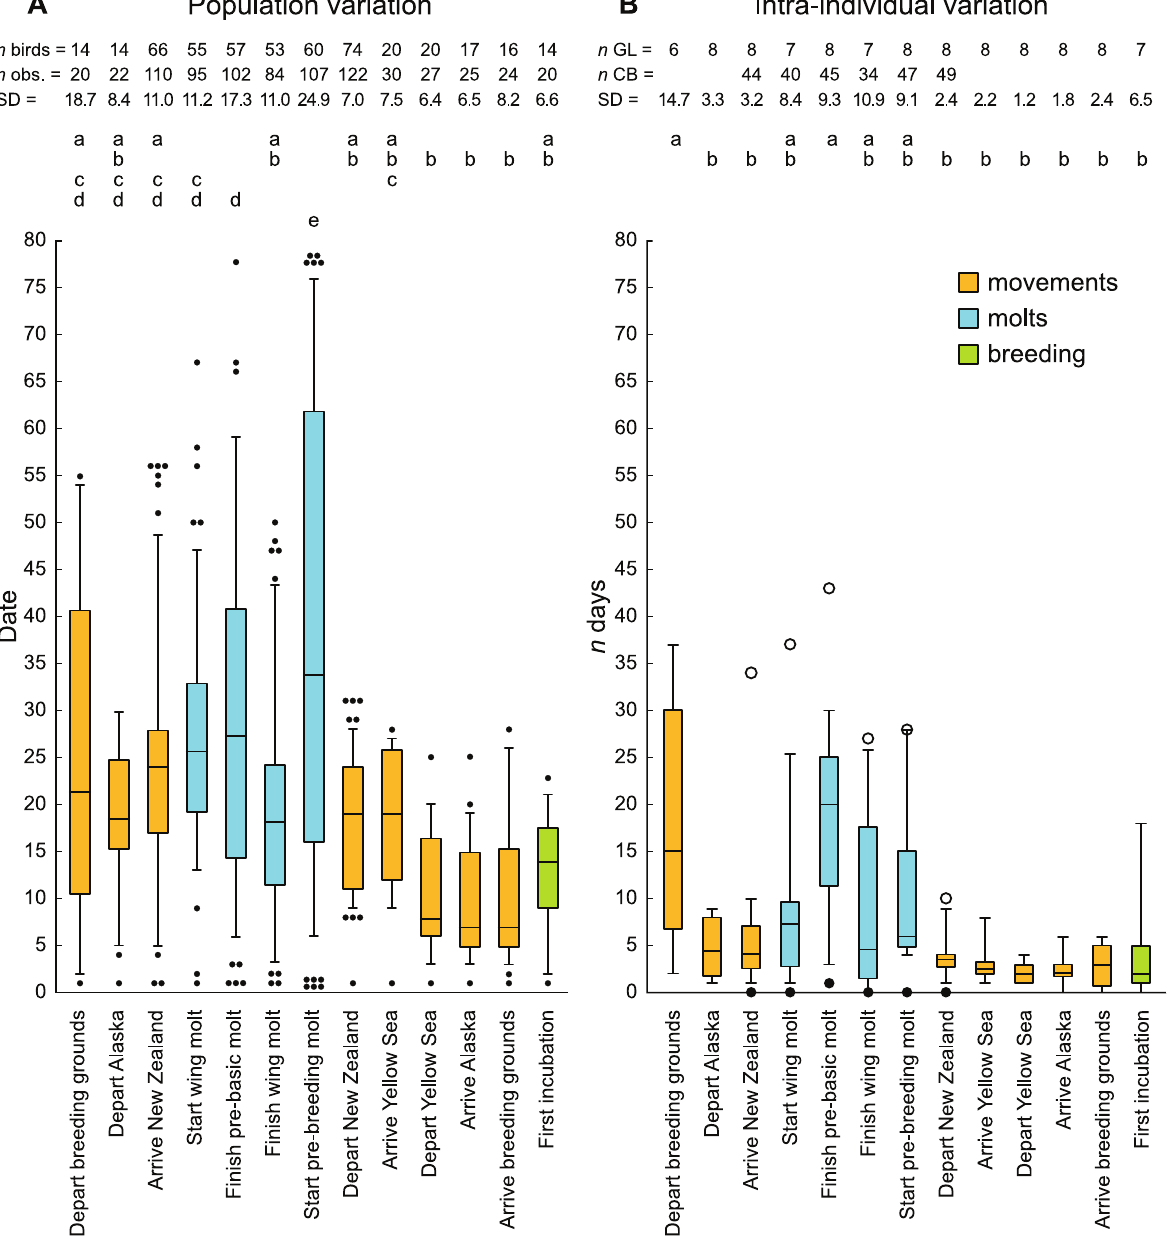
At the population level, temporal variation (SD) decreased chronologically from post-breeding departure to start of incubation (Spearman-rank: r s =0.71, n =13, P =0.003). Intra-individual vari- ation also decreased chronologically across all stages (mean: r s =0.72, n =13, P =0.003; SD: r s =0.59, n =13, P =0.016). Individual